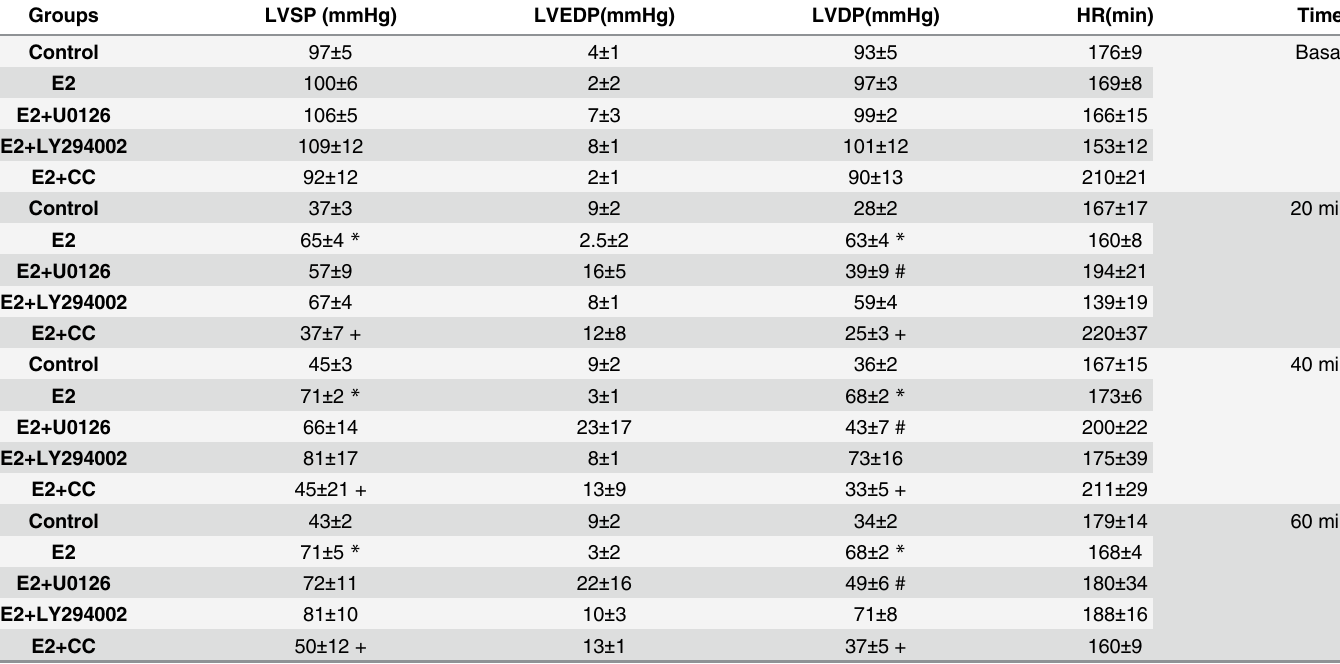
Cardiac functional parameters in WT male mice. Left ventricular systolic pressure (LVSP); left ventricular end-diastolic pressure (LVEDP); left ventricular developed pressure (LVDP) and heart rate (HR) before ischemia (Basal) and at different times of reperfusion after I/R in control, E2-treated, and E2+Inhibitors (U0126, LY294002 and CC: chelerythrine chloride). Values are mean ±